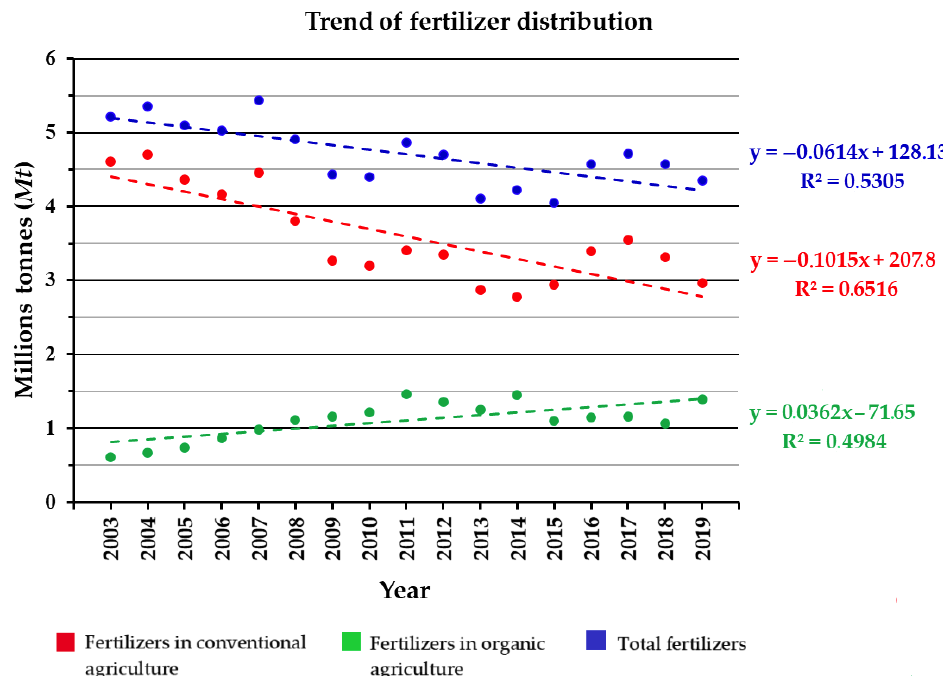
Figure 2. Trends of the fertilizer distribution, in million tons of the main nutrient elements, in Italy from 2003 to 2019. The upper blue line is for total fertilizer consumption and is equivalent to the sum of all kinds of fertilizer products used in both conventional (red line) and organic (green line) agriculture. The equation and the R-square value of the linear regression trendlines are displayed on the right of the graph. Total fertilizers include all types of fertilizers reported in Table 3. Data source: ISTAT (https://www.istat.it/en/legal-notice, accessed on 20 June 2020), [18].